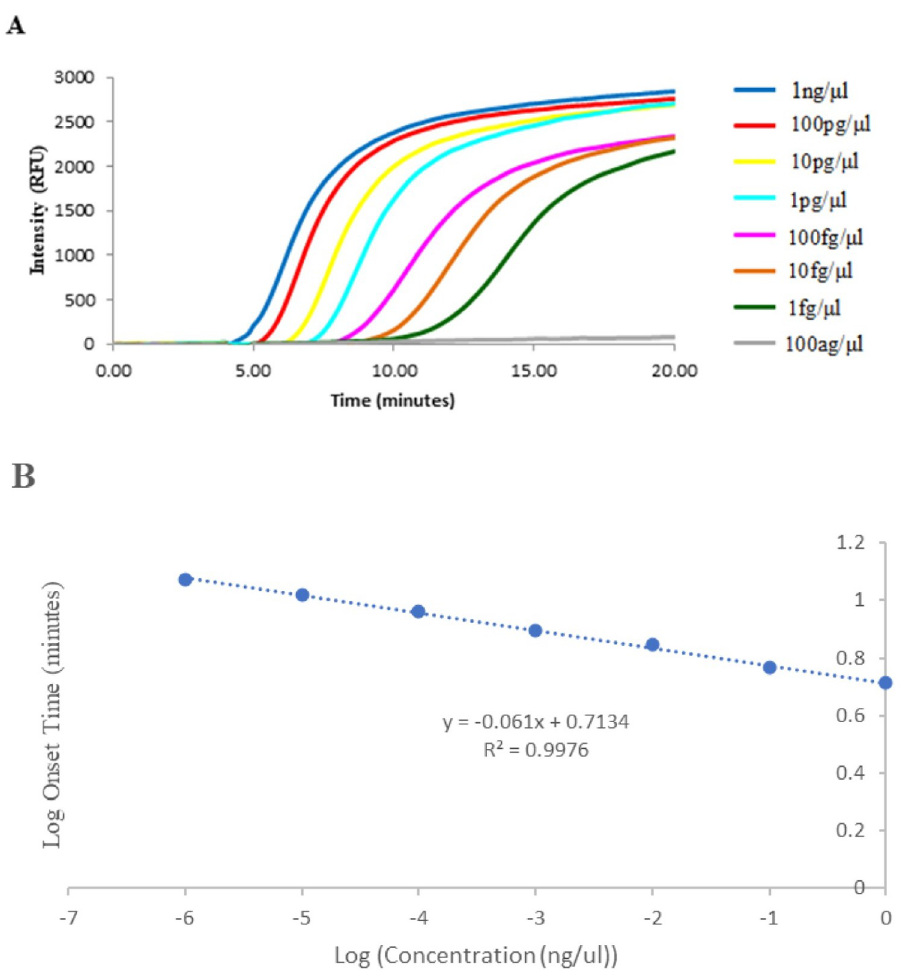
Fig 2. Detection limits of the RPA assay for potato mop-top virus (PMTV). (A) Serial dilution of PMTV RNA in water exhibited uniform amplification and detection from 1 ng/ μ L to 1 fg/ μ L. (B) Logarithmic comparison of the onset time to the concentration of RNA template generated a linear prediction curve, allowing for a quantitative analysis of purified RNA template.